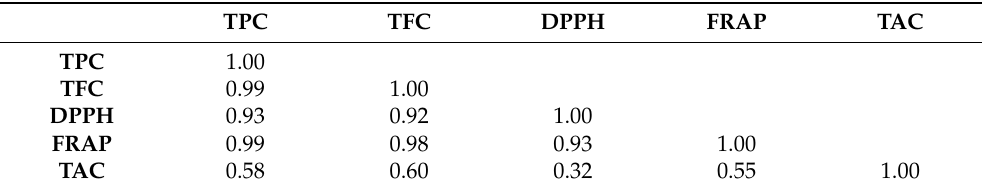
Table 2. Correlation coefficients obtained for the relationships between total polyphenols, total flavonoids, and antioxidant assays. TPC TFC DPPH FRAP TAC